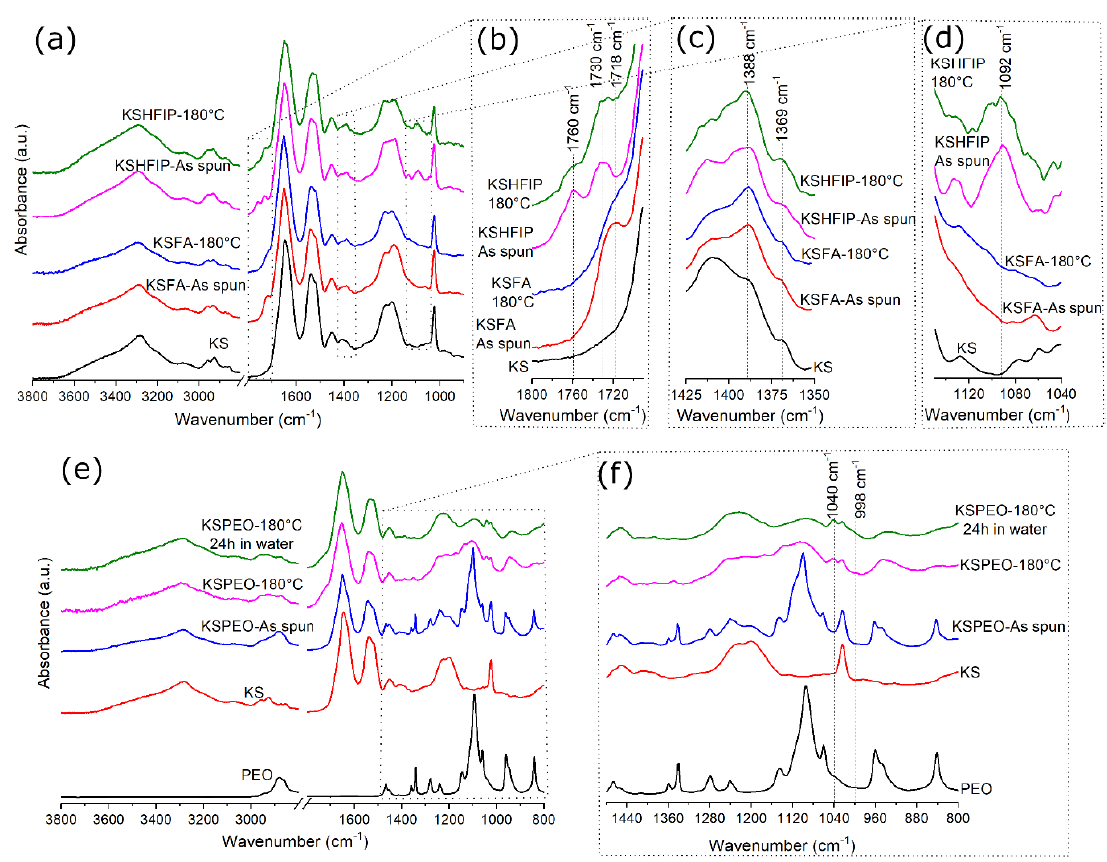
Figure 2. FTIR spectra before and after post-treatment at different wavenumber ranges. From ( a – d ): the first row corresponds to KS-NFs made of pure KS in solvents; ( e , f ): the second row corresponds to KS-NFs made of KS and PEO in water–KS (lyophilized powder) and PEO